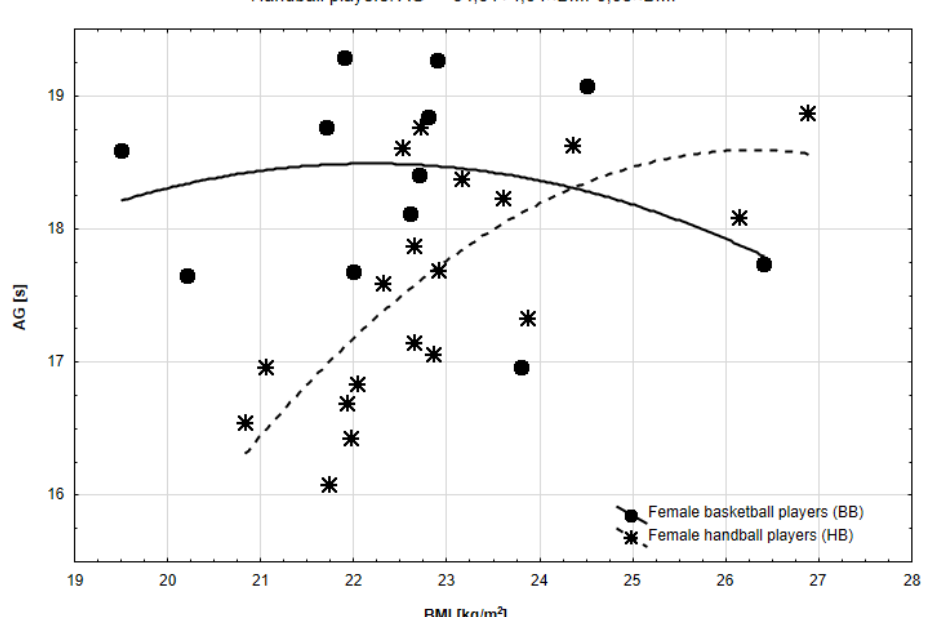
Figure 5. Functional forms of the relationships between BMI and AG in BB and HB.